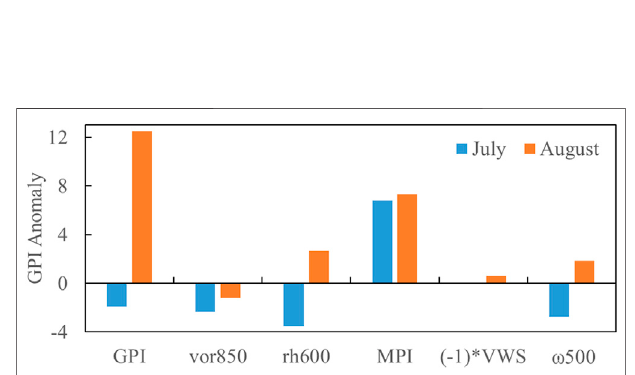
FIGURE 4 | Anomalies of the total GPI and fi ve terms associated with GPI averaged in the region of (5 ° -25 ° N, 110 ° -140 ° E) in July and August 2020,